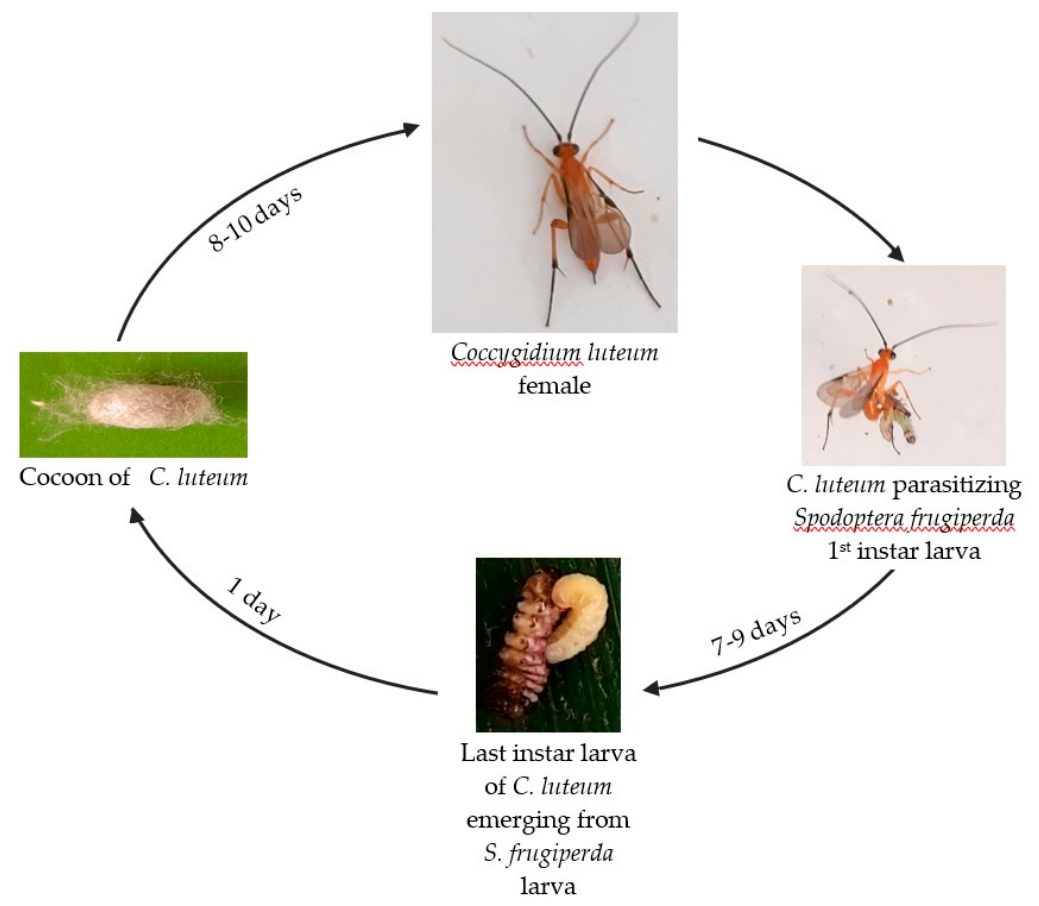
Figure 1. Generalized generation time of Coccygidium luteum.